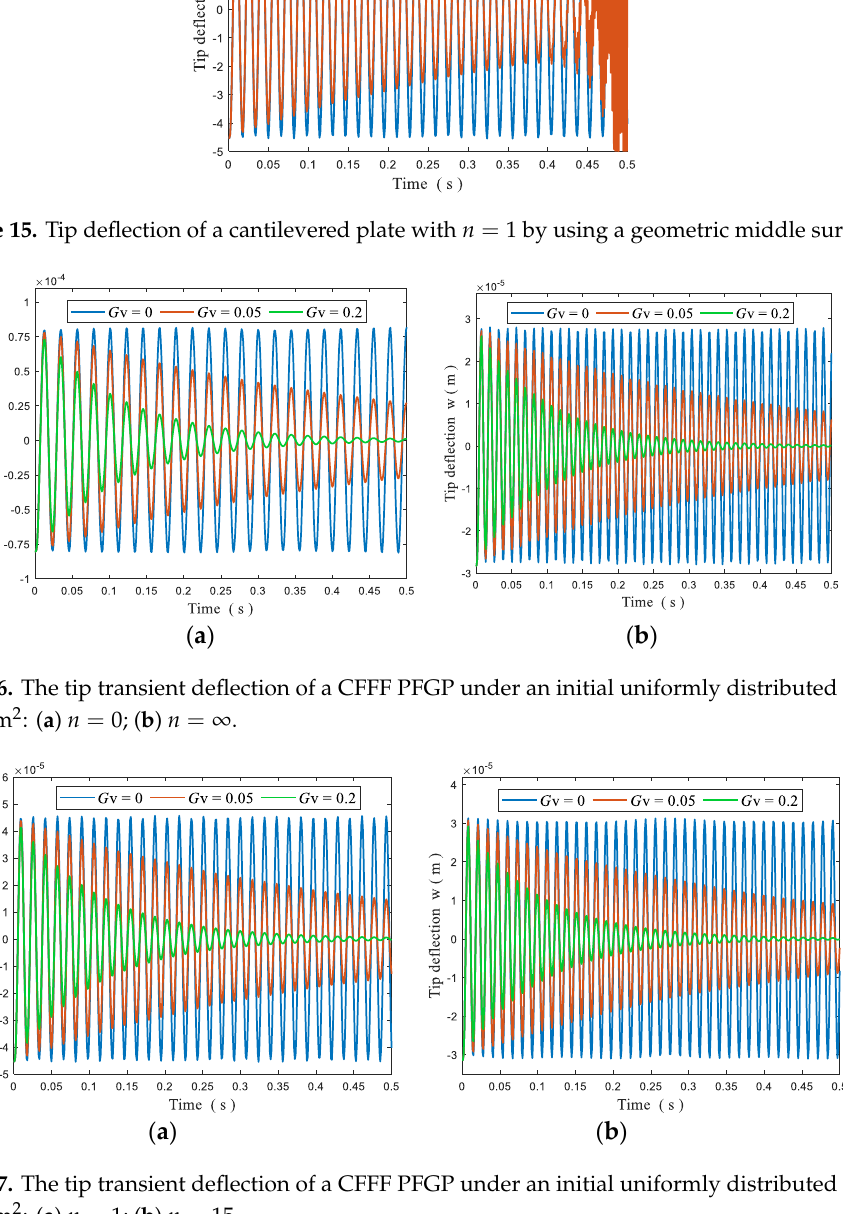
− 100 N / m 2 : ( a ) n = 1; ( b ) n = −100 N/m 2 : ( a ) −100 N/m 2 : ( a )